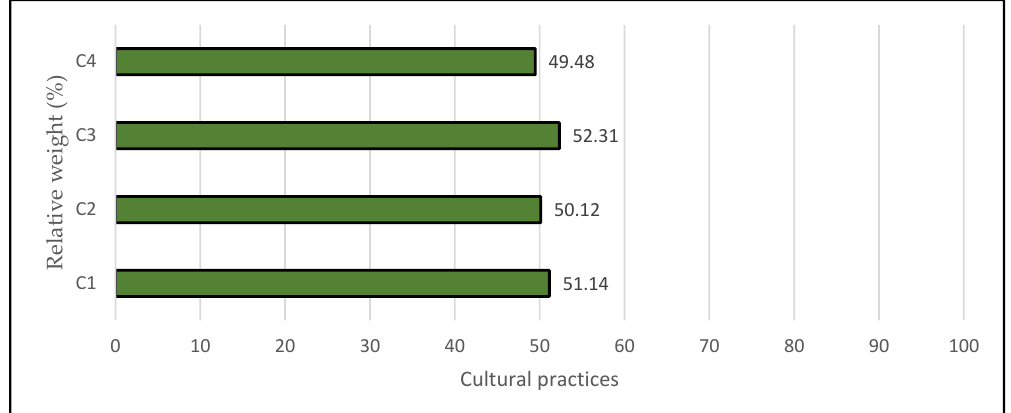
Figure 3. Farmers’ adoption of legislative control pra ctices for red palm weevil control. (L1 = adher- ing to the measure against transferring infested trees or offshoots to non-infested areas, L2 = burning and burying the infested palm far away after cutting it into small portions, L3 = adhering to the measure against transferring infested palm waste to other areas, L4 = surveying RPW-infested palms and informing the authorities when necessary, L5 = not allowing anyone to transfer infested off- shoots from an infested farm).